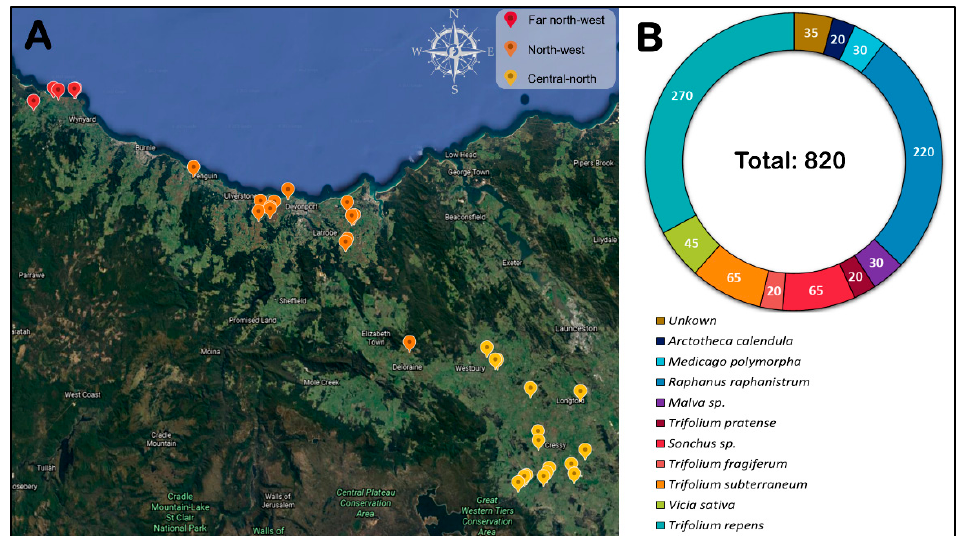
Figure 1. ( A ) Map of the three different pea crop sampling regions (far northwest, northwest, and central north) in Tasmania. ( B ) Details of weeds and pasture species samples collected from all sites prior to pea crop sowing.